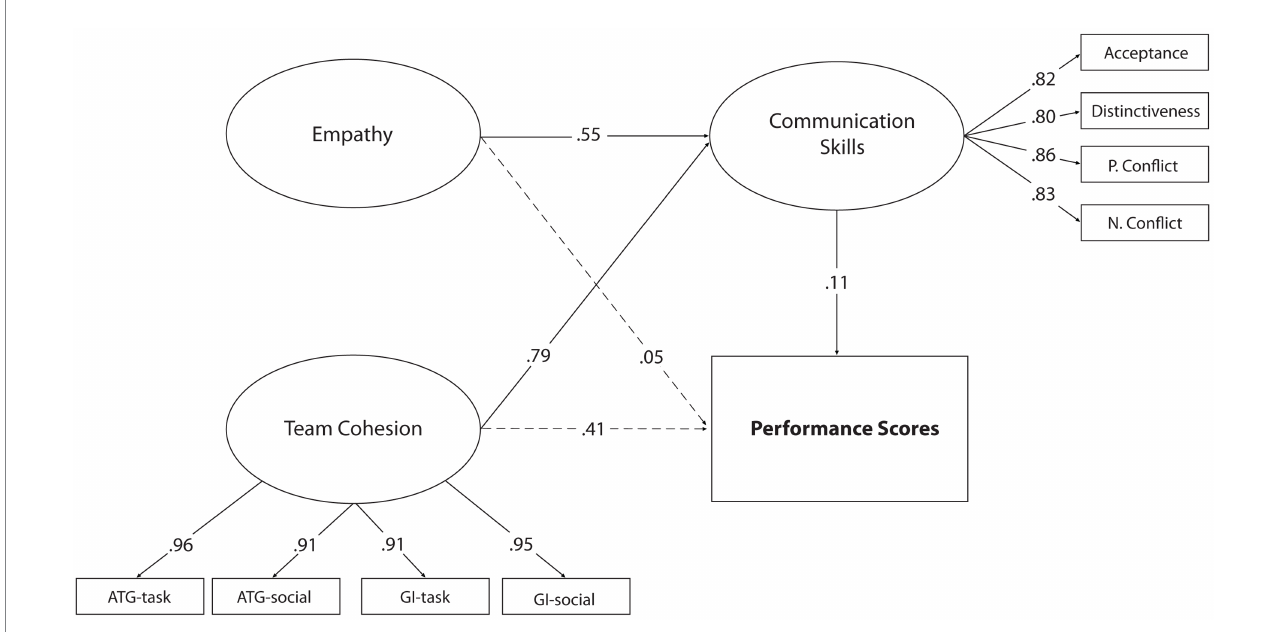
FIGURE 2 Standardized SEM results for Model 2.